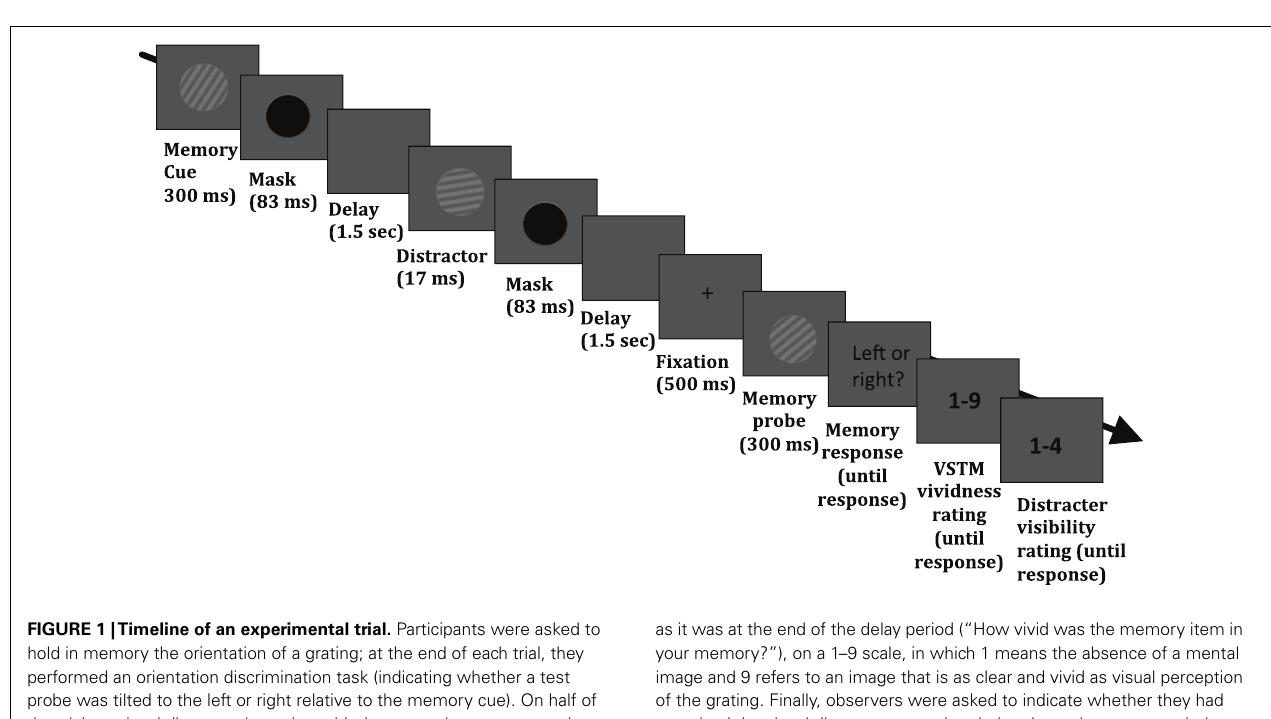
FIGURE 1 |Timeline of an experimental trial. Participants were asked to hold in memory the orientation of a grating; at the end of each trial, they performed an orientation discrimination task (indicating whether a test probe was tilted to the left or right relative to the memory cue). On half of the trials, a visual distracter (a grating with the same size, contrast and spatial frequency as the memory cue) was presented in the middle of the delay period; the orientation of this distracter could be identical to that of the memory cue, or it could differ by 10˚ or 40˚. In addition, participants were asked to rate the subjective vividness of their memory representation